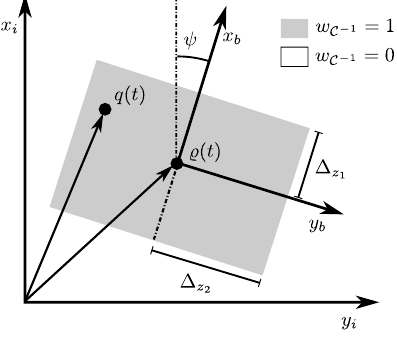
Figure 4: The non-smooth sampling function is one for q ( t ) inside the box and zero otherwise. x i and y i denote the axes of the stationary reference